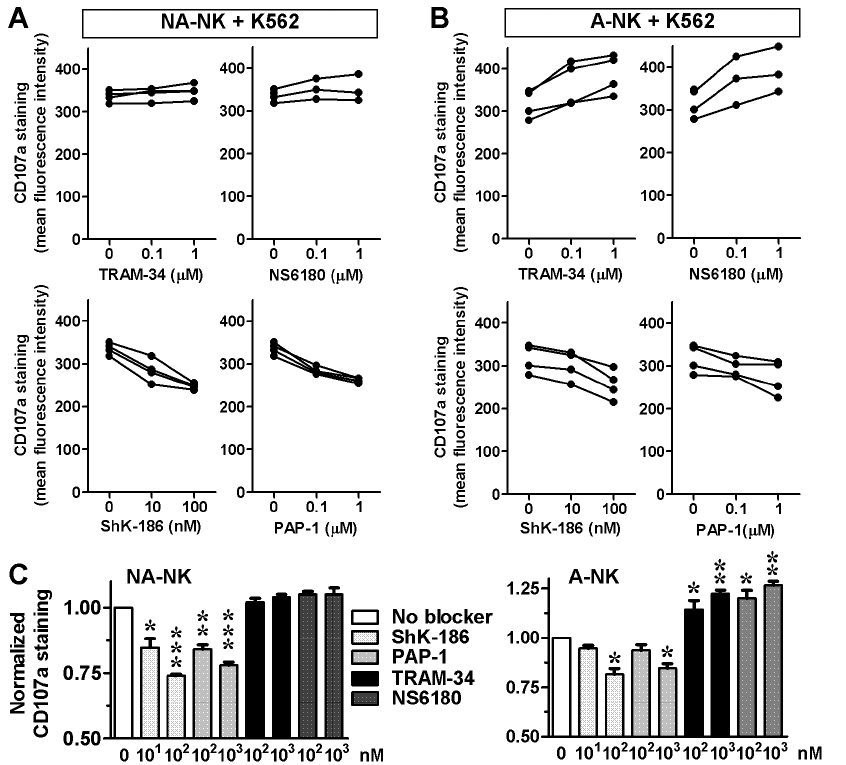
Figure 4. Blocking KCa3.1 and Kv1.3 differentially affects the degranulation of A-NK and NA-NK cells. A: Mean fluorescent intensity of CD107a staining in NA-NK and A-NK cells in the presence of the concentrations of blockers indicated on the X-axis of each plot. Each data point represents the mean of duplicate assays on single donors. B: CD107a expression levels in NA-NK and A-NK cells in the presence of K562 cells without potassium channel blockers (white) or in the presence of ShK-186 (10 and 100 nM; light grey), PAP-1 (0.1 and 1 m M; medium grey), TRAM-34 (0.1 and 1 m M; black), or NS6180 (0.1 and 1 m M; dark grey). Data represent the mean 6 SEM of data obtained in triplicate in independent assays with cells from the donors shown in panel A. *p , 0.05, **p , 0.01, ***p ,